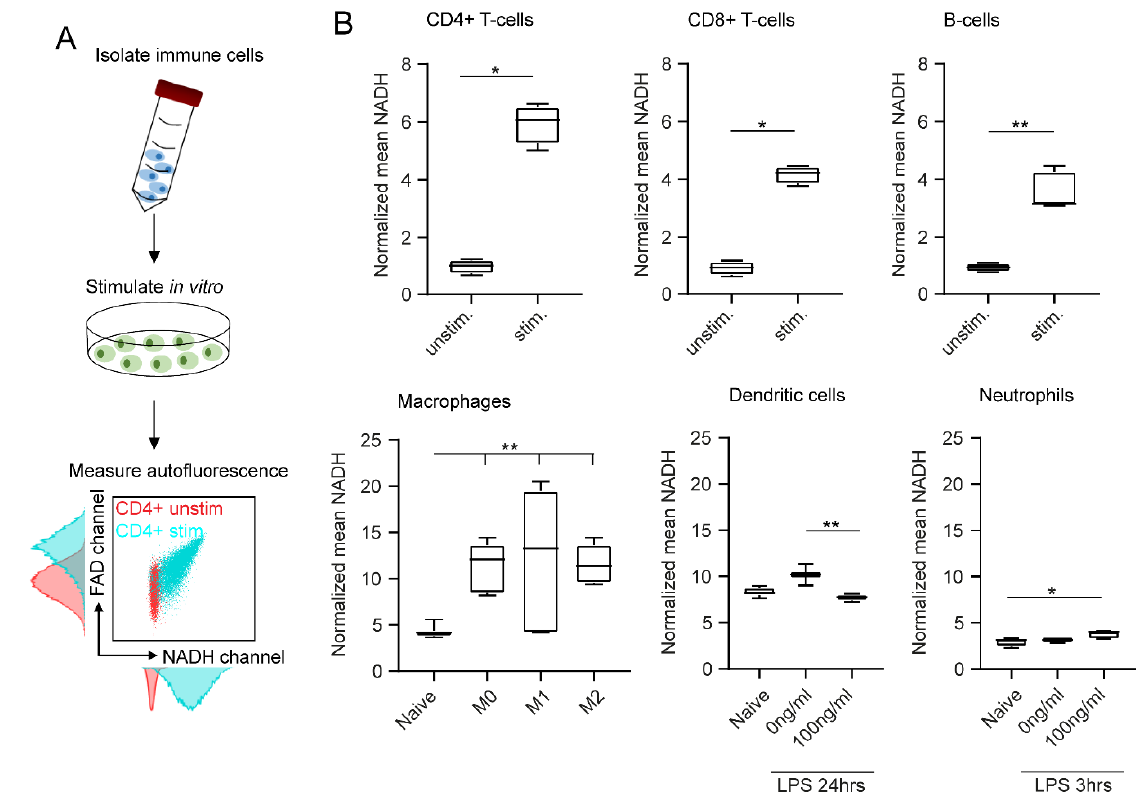
Figure 2. In vitro stimulation affects immune cell autofluorescence in flow cytometry. ( A ) After in vitro stimulation, immune cell autofluorescence was assessed by flow cytometry. ( B ) Boxplots showing NADH autofluorescence of adaptive and innate immune cells before and after in vitro stimulation. Statistical significance was analysed with a Mann–Whitney test for comparing two independent groups. For three independent groups, a Kruskal–Wallis test with subsequent Dunn’s multiple comparisons test was used (* p < 0.05, ** p < 0.01). At least three samples per group were analysed. Each sample reflects either cells isolated from one mouse (unstimulated CD4+ T cells, CD8+ T cells, B cells, neutrophils) or cells cultured in one culture dish (stimulated CD4+ T cells, CD8+ T cells, B cells, neutrophils; unstimulated and stimulated macrophages, dendritic cells).